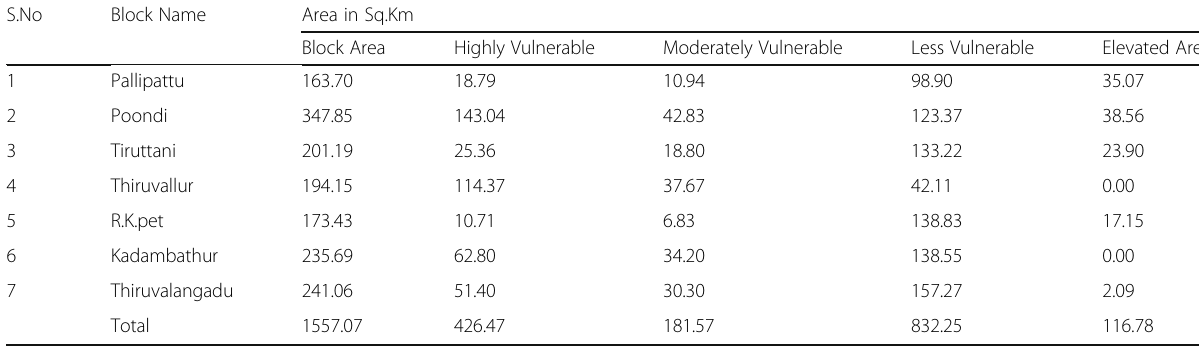
Table 7 Block-wise spatial distribution of flood vulnerable zones